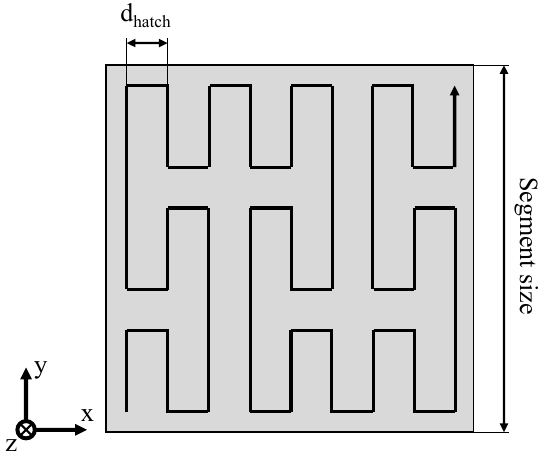
Figure 3. Schematic depiction of the applied fractal exposure pattern. Quasi-simultaneous exposure of varying geometries is based on the repetitive, con- secutive exposure of distinct fractal patterns. Each sub-segment constitutes a closed loop, allowing for an uninterrupted quasi-simultaneous exposure, schematically displayed in Figure 4.